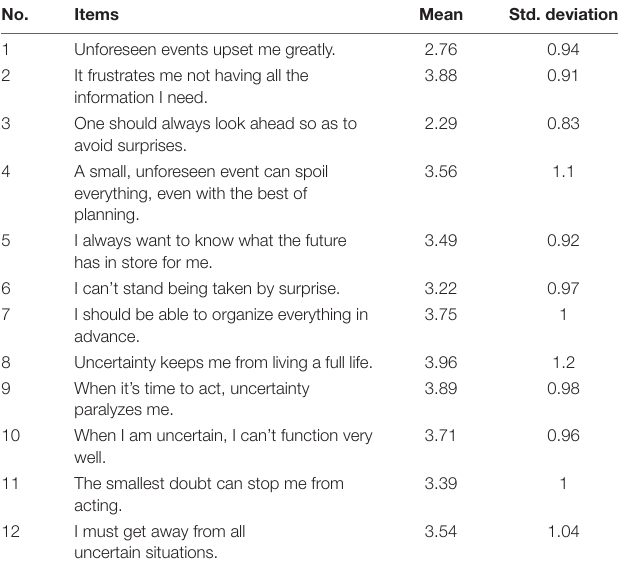
TABLE 2 | Means and standard deviations of the items of intolerance of uncertainty scale-12. No. Items Mean Std. deviation